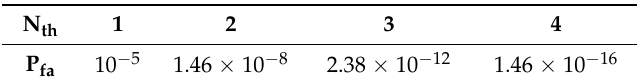
(cid:2916)(cid:2911) of each threshold N (cid:2930)(cid:2918) .